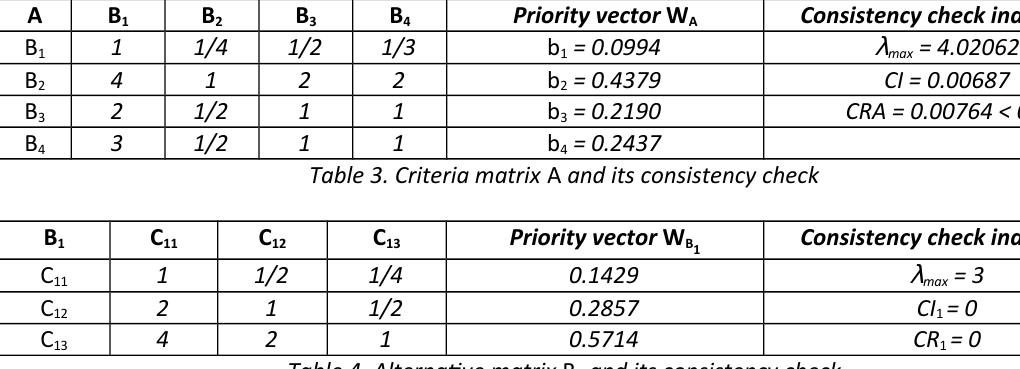
Table 4. Alternative matrix B